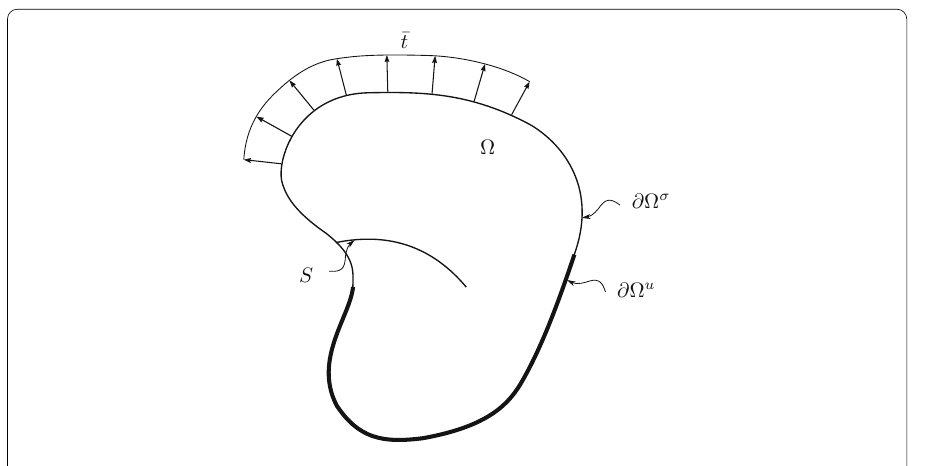
Fig. 1 Fractured domain ¯ (cid:2) in R 2 or R 3 . This figure presents a general fractured